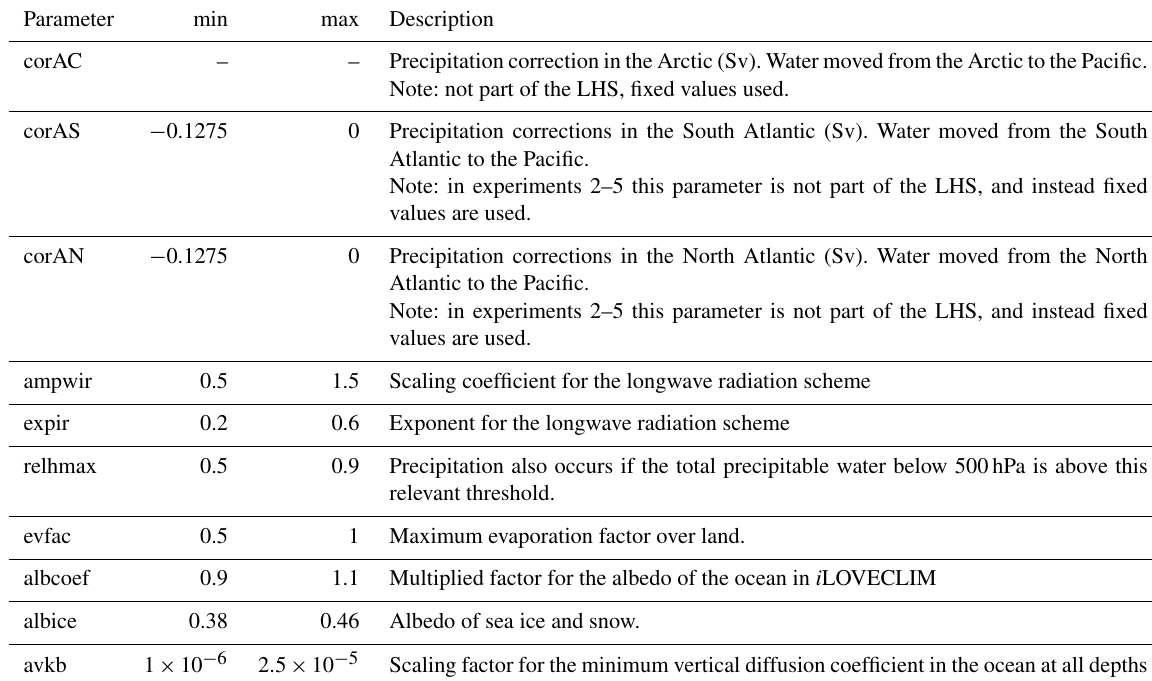
Table A2. Meaning of the 10 parameters that are in used to construct the perturbed-parameter ensemble. Also given are the minimum and maximum values that are used in the LHS procedure.